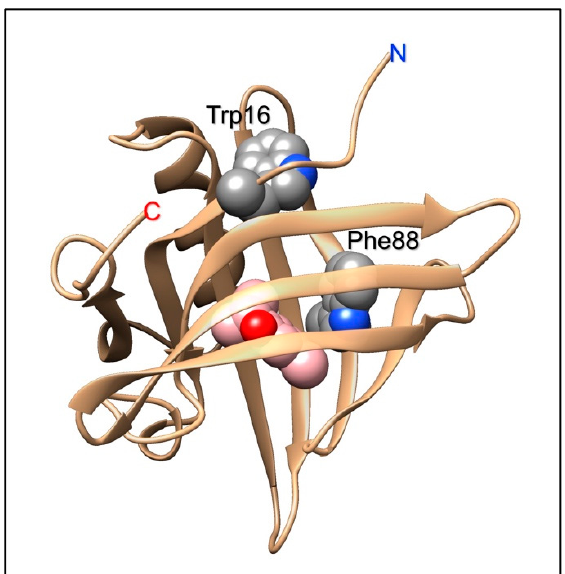
Figure 2. Structure of the pig OBP1. Tryptophan 16 is part of the lipocalin signature and is located outside the binding pocket. In a mutant designed to act as biosensing element for polyaromatic hydrocarbons, phenylalanine 88, which is located inside the binding pocket, was mutated into a second tryptophan residue, that would act as fluorescent reporter to monitor the presence of aromatic ligands in the binding site.